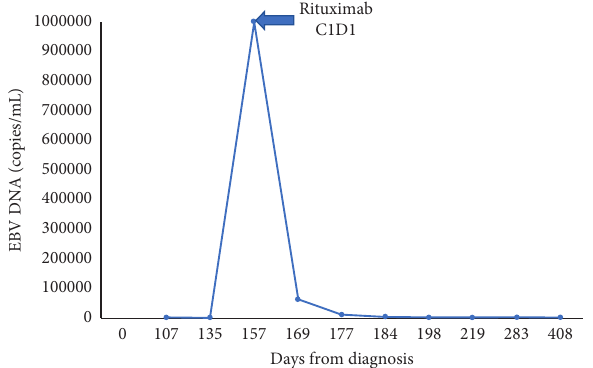
Figure 2: Epstein–Barr virus (EBV) viral loads over time. Day 0 is defined as the day of diagnosis with EBV-positive lymphoproli- ferative disorder. EBV DNA quantification from the peripheral blood at various time points before and after starting rituximab therapy. C1D1 � cycle 1, day 1 of rituximab. EBV quantification was undetectable after 60 days following the start of rituximab